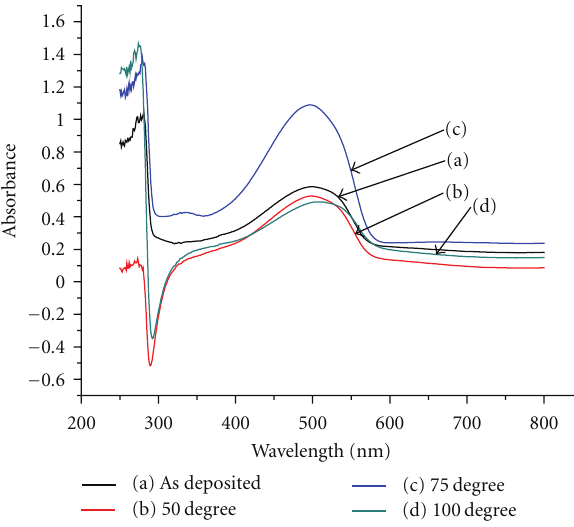
Figure 5: Absorbance spectra for nanocomposited MEH-PPV:CNTs for di ff erent heating